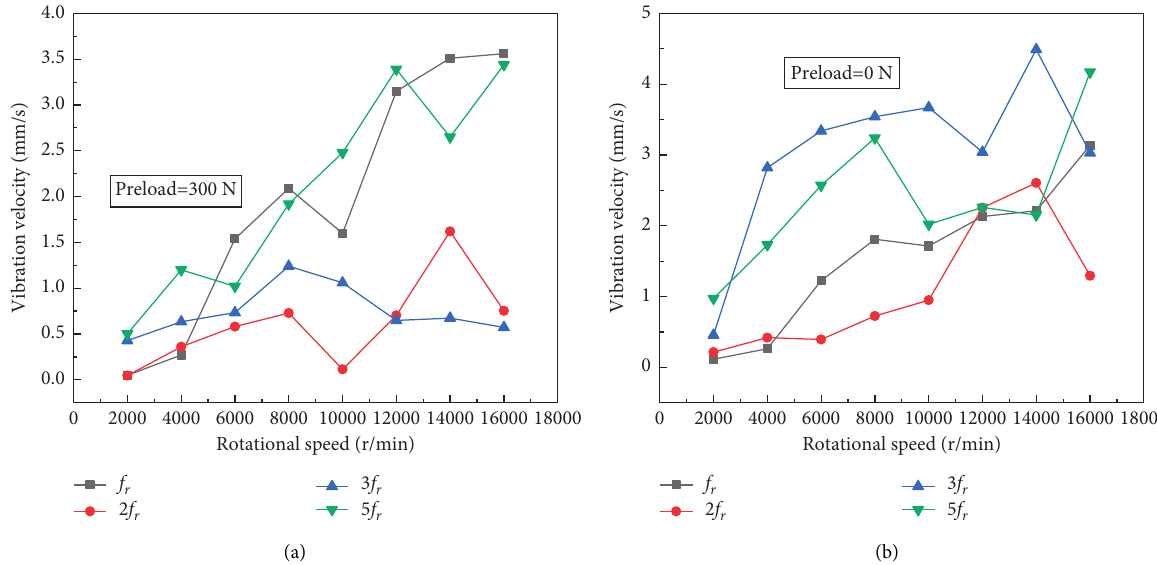
Figure 11: Effect of frequency multiplication on the vibration velocity for steel bearings under grease lubrication condition. (a) Condition of applying preload. (b) Condition of no